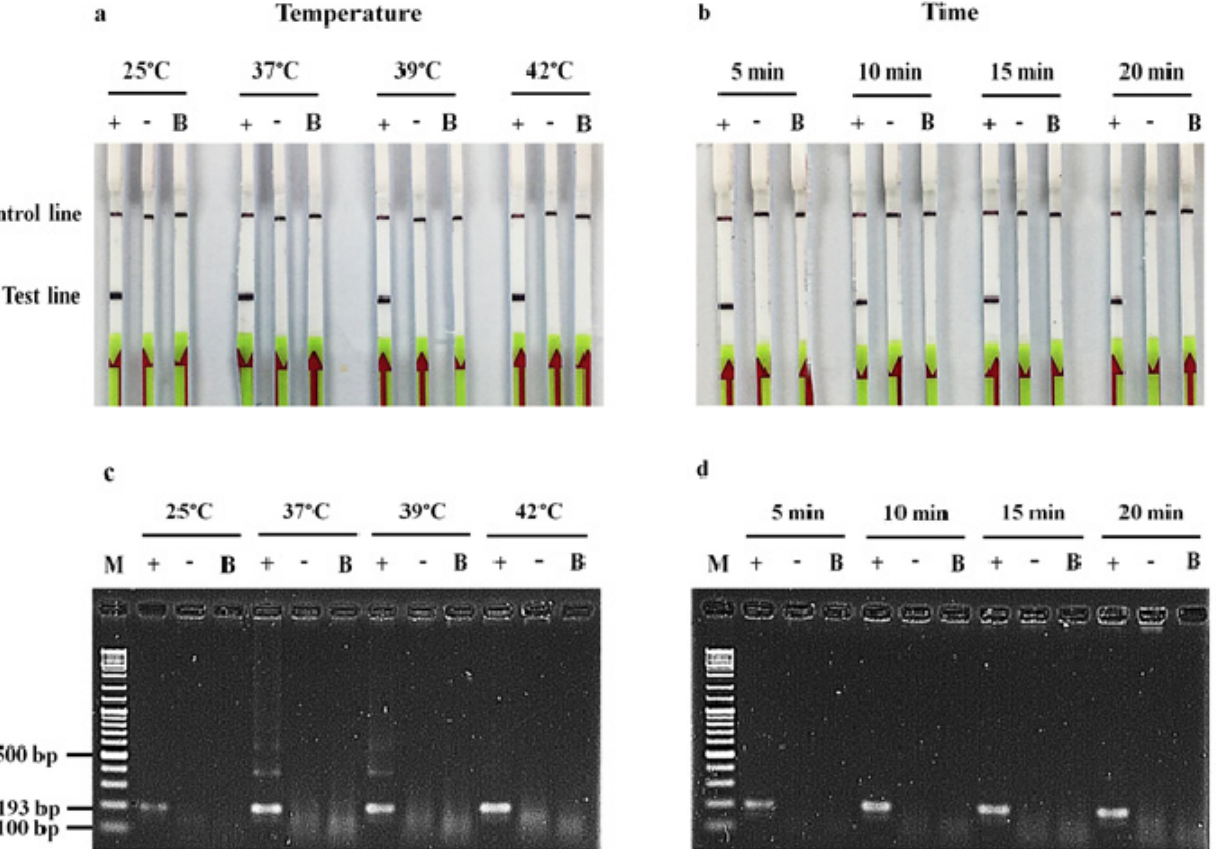
Figure 1. Optimization of the RPA-LF conditions, amplification temperature ( left ) and incubation time ( right ), for identification of the bla OXA-48-like . The RPA products were detected by lateral flow strip ( a , b ), and agarose gel electrophoresis ( c , d ). M, 100 bp DNA ladder; +, bla OXA-48-like positive control strain; -, negative control strain; and B,